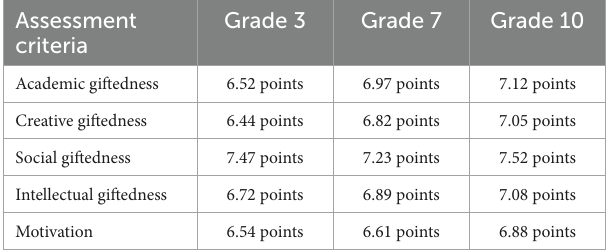
TABLE 1 Preliminary findings on student giftedness.